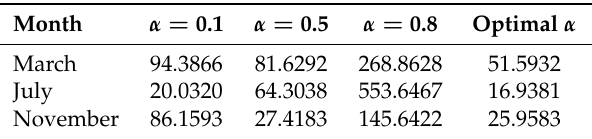
Figure 6. Analysis of the effects of α value in the semiparametric estimators for March, July and November in Fold 4. Table 4. The weighted sum squared error of semiparametric semivariogram with different α for March, July and November in Fold